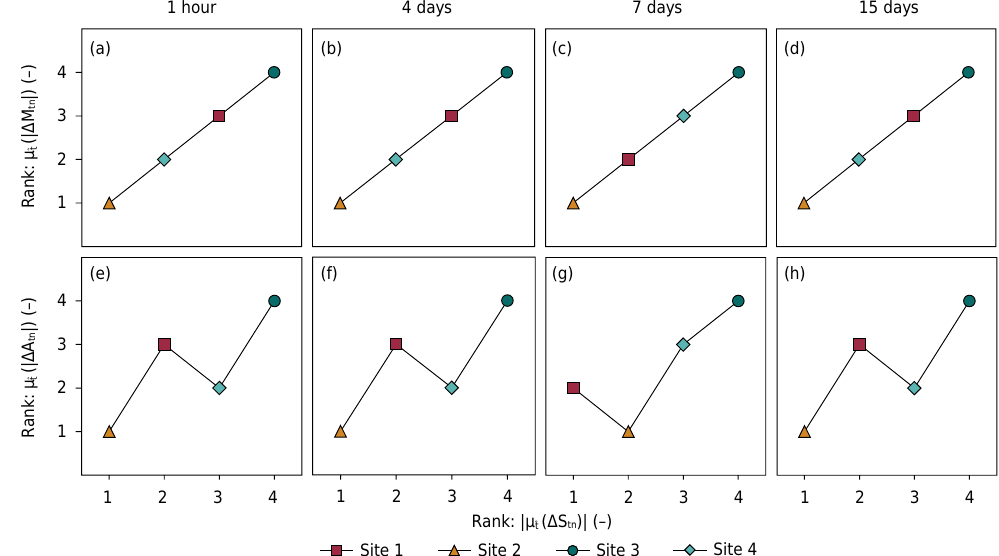
Figure 7. Scatter plots of absolute temporal mean ranking of absolute Soil Moisture (SM) differences [|µ t ̂ (ΔS tn )|] against the temporal mean ranking of absolute SM temporal mean differences [µ t ̂ (|ΔM tn |)] (a, b, c, and d) and temporal mean ranking of absolute SM temporal anomaly differences [µ t ̂ (|ΔA tn |)] (e, f, g, and